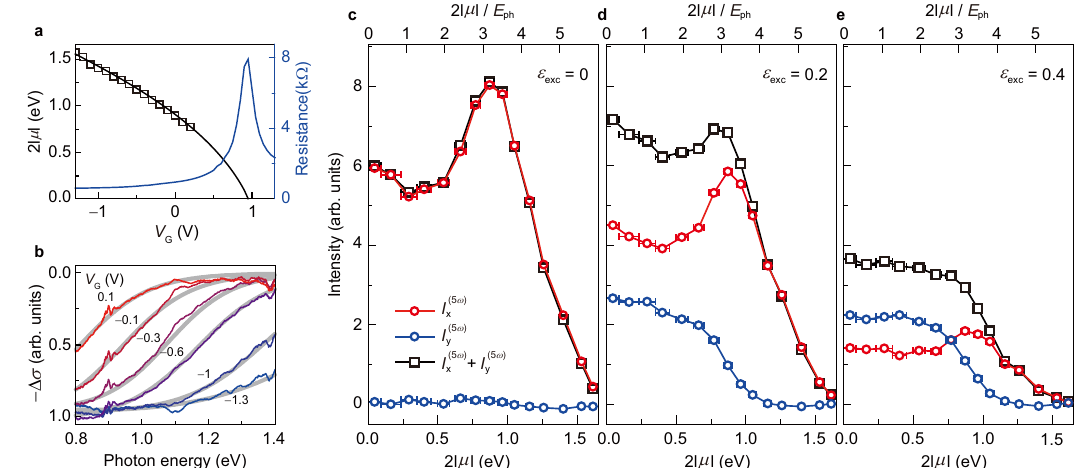
Fig. 2 | Intensity of the fi fth harmonics as a function of the chemical potential ( μ ). a Electrical transport measurement of the graphene channel. Resistance (blue solid line) shows the maximum at the gate voltage V G of 0.95V, identifying the charge-neutral case ( μ =0eV). b Infrared transmission measurement of the gra- phene device. As V G decreases from 0.1V to − 1.3V, a step-like absorption edge moves to higher energy. Fitting to the model based on Kubo formula (gray solid lines) determines μ which is summarized in a with black squares. c – e Harmonic intensity as a function of 2 ∣ μ ∣ (or 2 ∣ μ ∣ = E ph where E ph is laser photon energy). I ð 5 ω Þ x